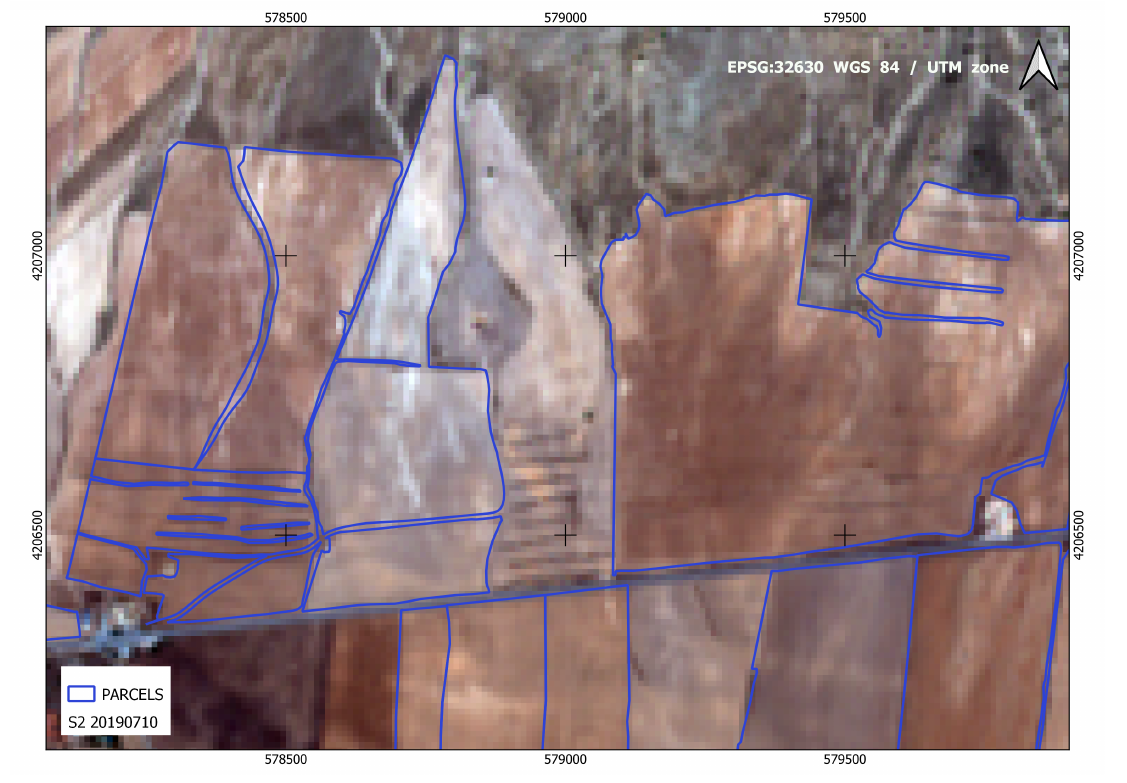
Figure 5. BirdsML methodology scheme.